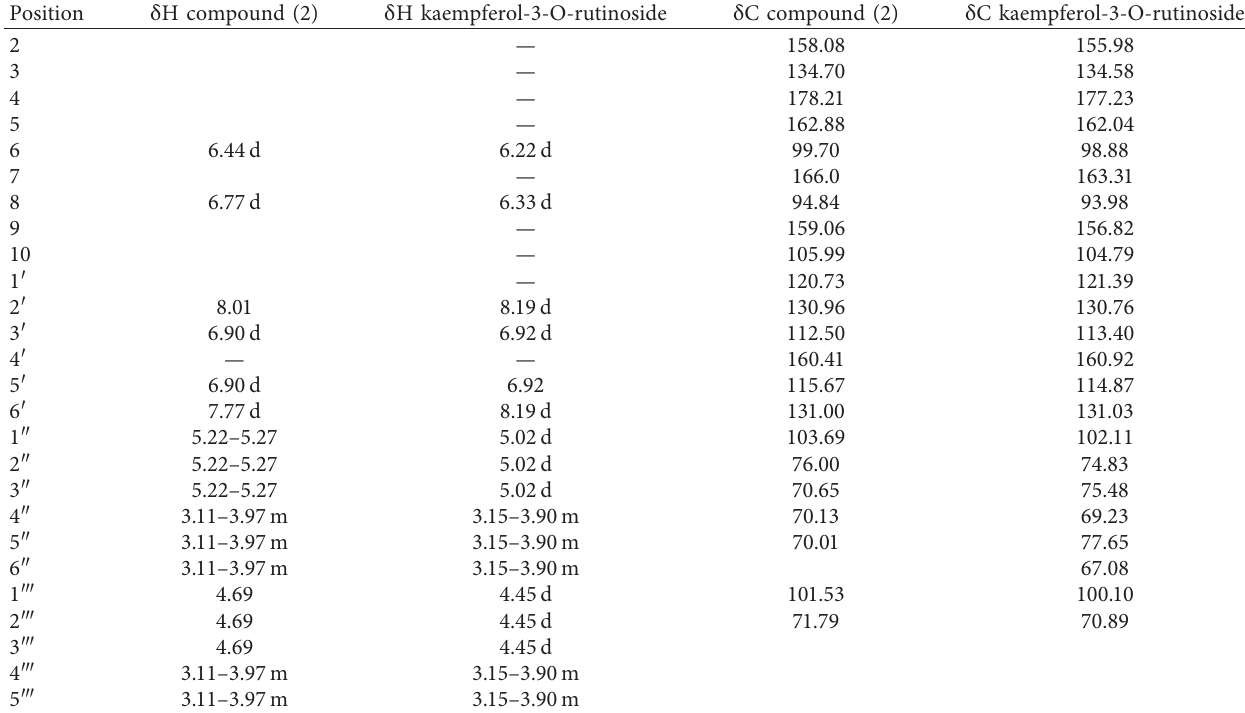
Table 5: 1H- and 13C-NMR assignments of compound 1 (500 MHz, DMSO) in comparison with reported data for kaempferol-3-O- rutinoside (100MHz, CD3OD) [27].